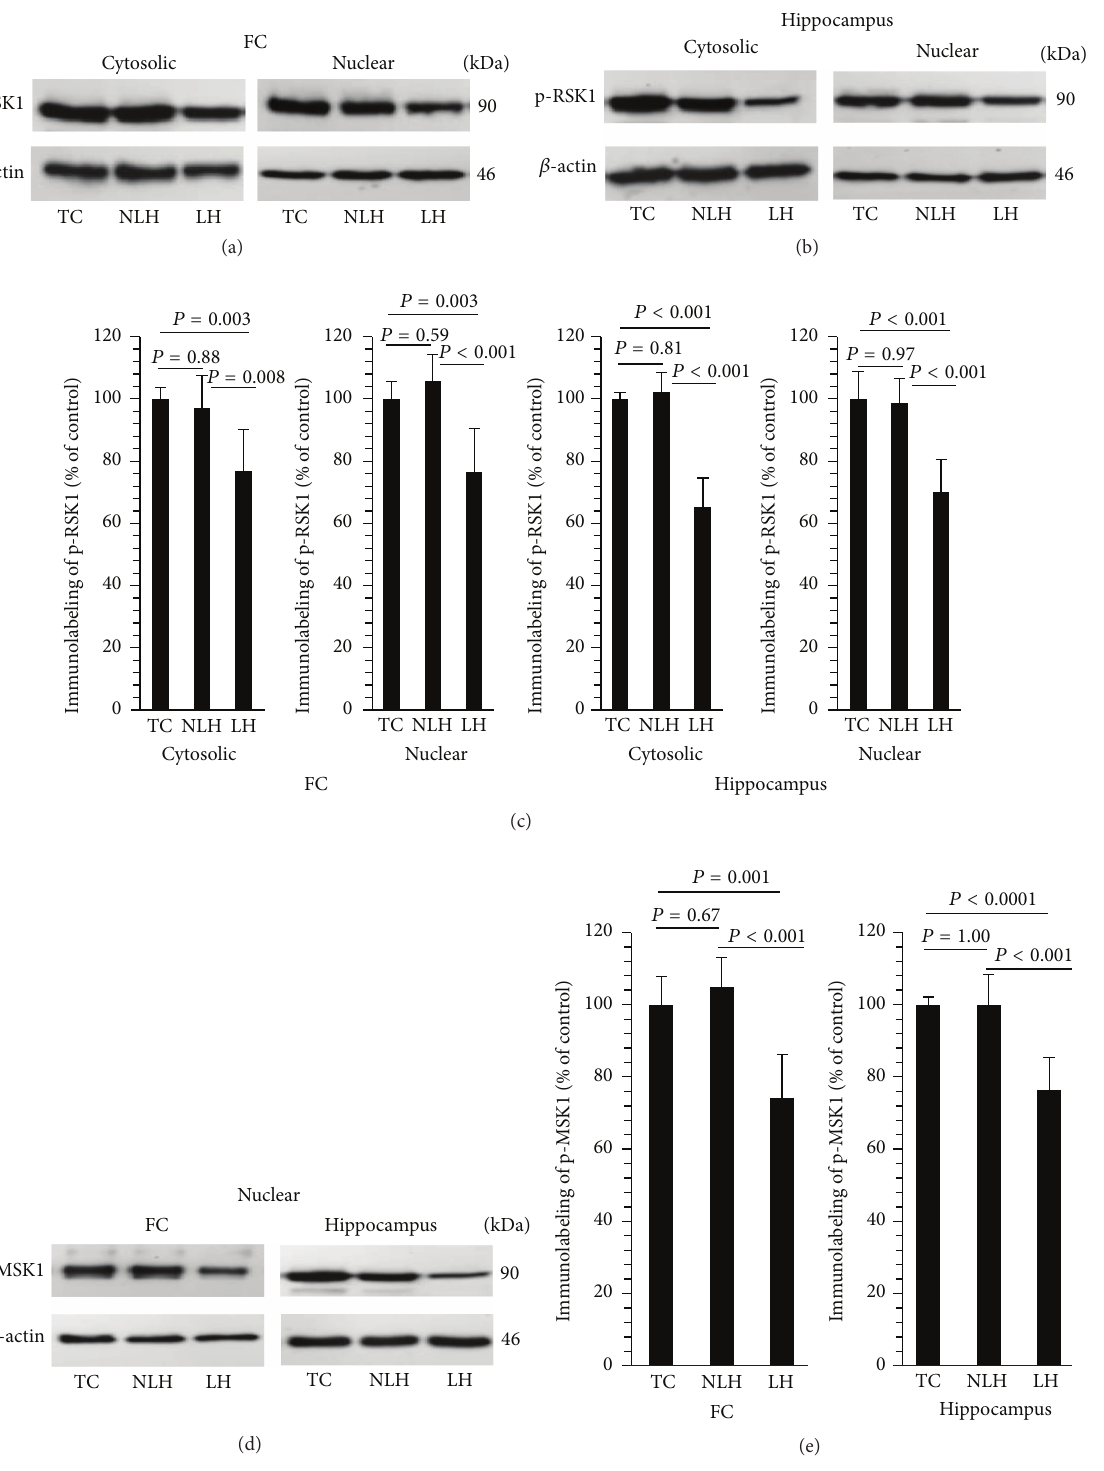
Figure 7: Representative Western blots showing ERK1/2-mediated phosphorylation of RSK1 in cytosolic and nuclear fractions of frontal cortex (FC) (a) and hippocampus (b) and MSK1 in nuclear fraction of FC and hippocampus (d) obtained from tested control (TC), non- learned helpless (non-LH), and learned helpless (LH) rats. 𝛽 -actin was used as endogenous control. Differences in phosphorylation of RSK1 and MSK1 in FC and hippocampus between TC, non-LH, and LH rats are shown in (c) and (e), respectively. Data are the mean ± SD from 6 rats in each group. Overall group differences for RSK1 among TC, non-LH, and LH rats are as follows. FC: cytosolic, df = 2, 15 , 𝐹 = 9.62 , and 𝑃 = 0.002 ; nuclear, df = 2,15 , 𝐹 = 14.42 , and 𝑃 < 0.001 . Hippocampus: cytosolic, df = 2,15 , 𝐹 = 60.13 , and 𝑃 < 0.001 ; nuclear, df = 2, 15 , 𝐹 = 20.86 , and 𝑃 < 0.001 . Overall group differences for MSK1 in nuclear fraction among TC, non-LH, and LH rats are as follows. FC: df = 2, 15 , 𝐹 = 17.73 , and 𝑃 < 0.001 ; hippocampus: df = 2,15 , 𝐹 = 21.70 , and 𝑃 < 0.001